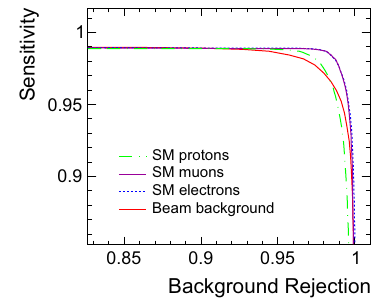
Fig. 14 ROC curve for different SM (standard model) background